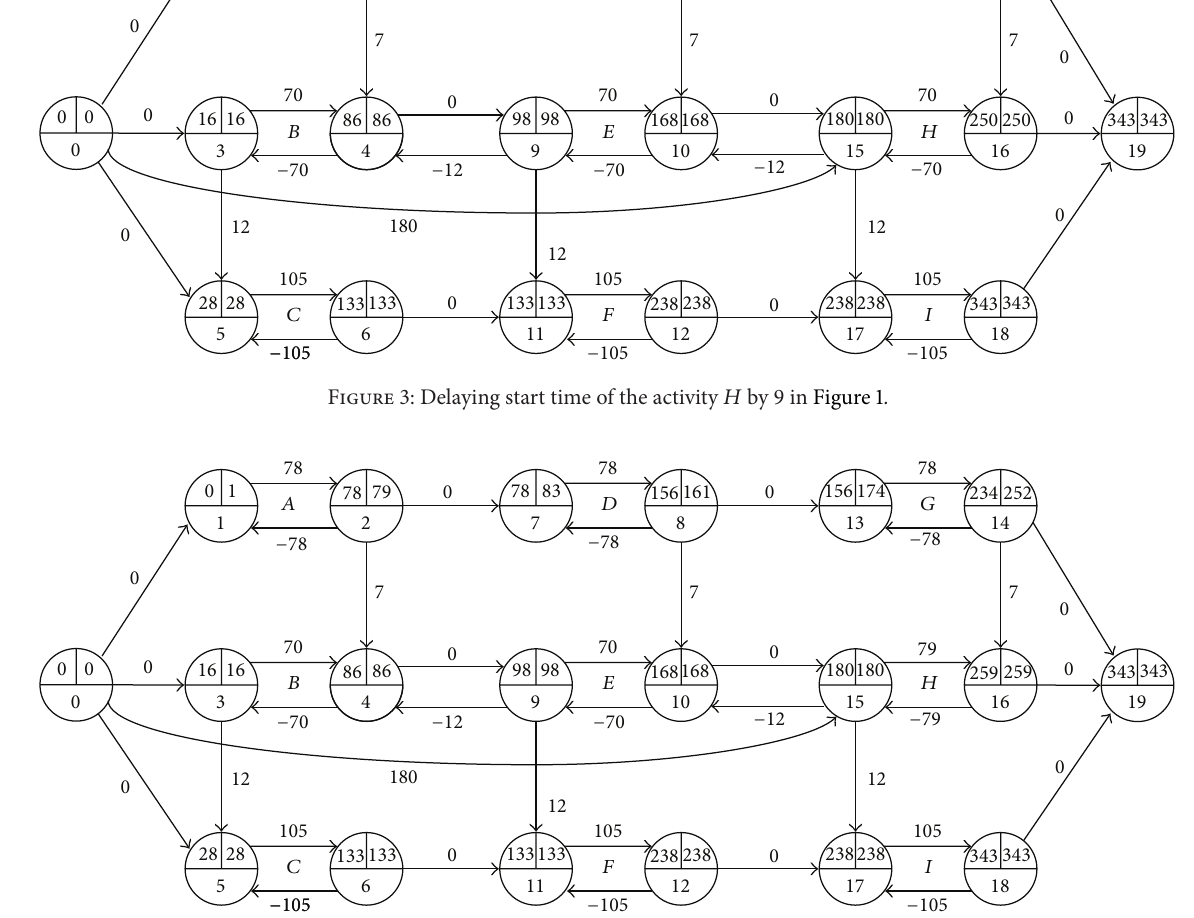
Figure 4: Delaying start time of the activity 𝐻 by 17 in Figure